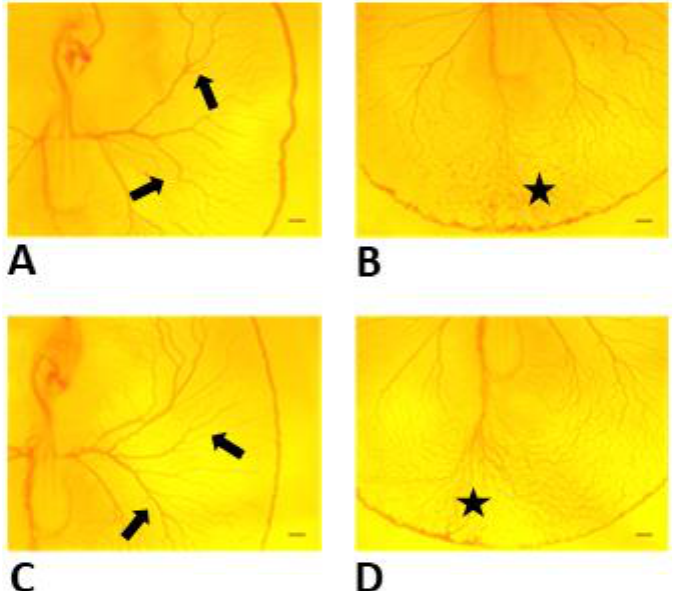
Figure 2. Development of extra-embryonic vasculature of chick embryos prior to treatment at 60 h incubation. Well-developed extra-embryonic vasculature ( A , C ; arrows) and blood islands in the tail region ( B , D ; asterisks) were evident prior to treatment. Control embryos were treated with vehicle ( A , B ), and embryos in the experimental group ( C , D ) received 500 µM of Y-27632. Scale bars 200 µm.